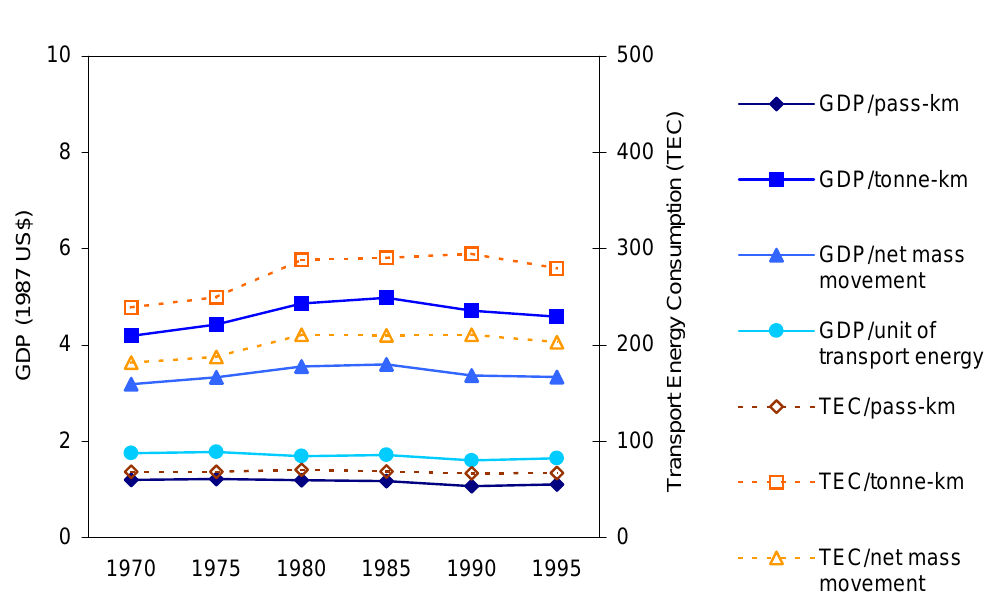
Figure 2. Transport Intensity for the UK using ‘conventional’ economic indicators, 1970-